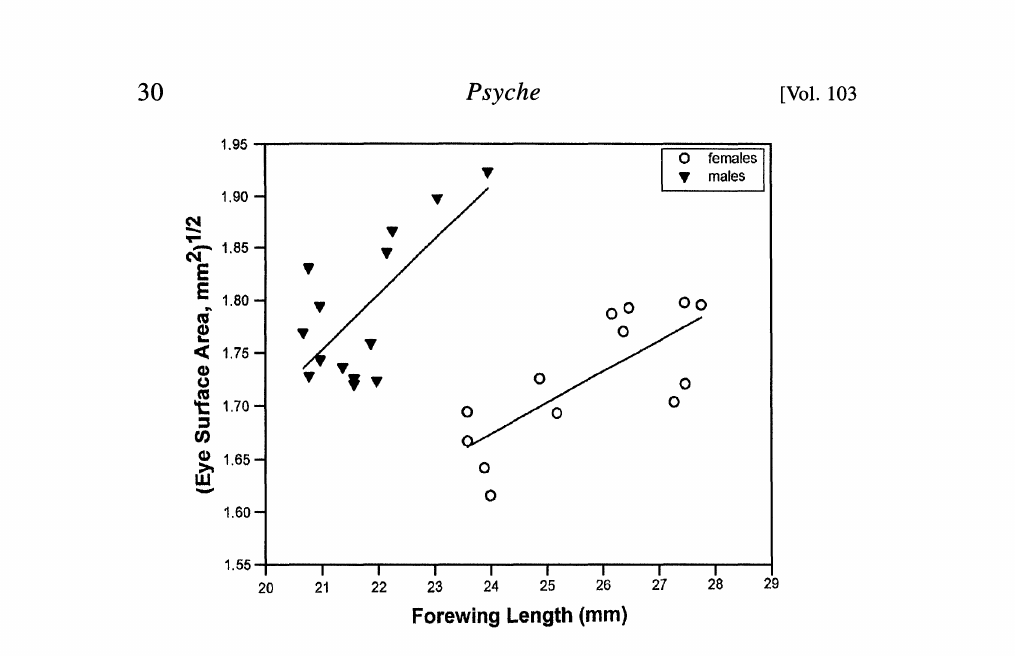
Fig. 2. Relationship between eye size and forewing length in A. leilia. Lines rep- resent least squares linear regression for males (’) and females (O).